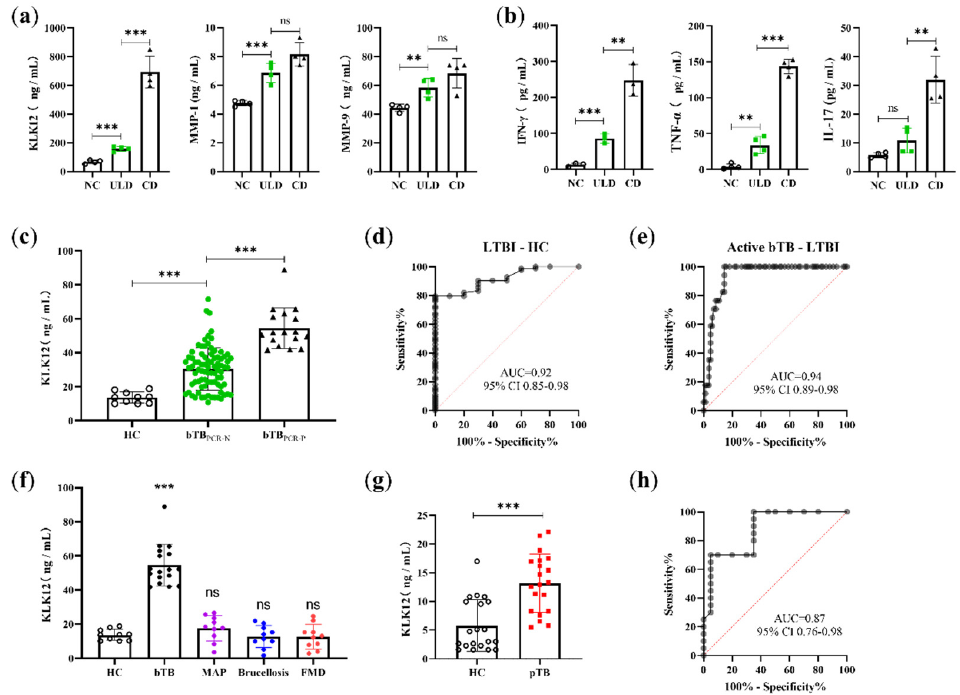
Figure 5. B6 mice ( n = 30) were intranasally infected with M. bovis (at doses of 200 CFU/mice or 2 CFU/mice) or with PBS. Four mice per group were sacrificed after 4 weeks of infection. ( a ) Sera were collected, and KLK12, MMP-1, and MMP-9 levels were determined by ELISA kits. ( b ) The cytokine (IFN- γ , TNF- α , and IL-17) levels in the sera of mice were detected by ELISA kits. ( c ) KLK12 levels in sera of healthy control (HC), bTB PCR-negative (bTB PCR-N ), and bTB PCR-positive (bTB PCR-p ) bovine samples were determined using ELISA kits. ROC curves were drawn to evaluate the potential of KLK12 for the diagnosis of ( d ) LTBI and ( e ) active bTB. ( f ) Then, the same ELISA kits were used to detect KLK12 in bovine serum infected with different diseases. ( g ) The ELISA kit was also used to detect KLK12 in the sera of healthy humans (HCs) and active pulmonary TB patients (pTB), and ( h ) an ROC curve was drawn according to the detection results. Analysis of data using GraphPad Prism software (** p < 0.01; *** p < 0.001). Table 1. Determination of the cutoff values for bTB and TB diagnosis.